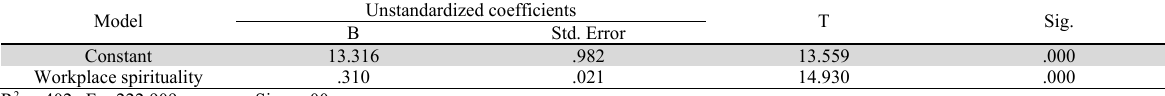
Relationship between Workplace spirituality and Mental wellbeing